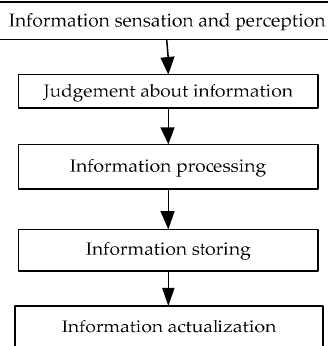
Figure 2. The scheme of knowledge mastering process when studying foreign language.